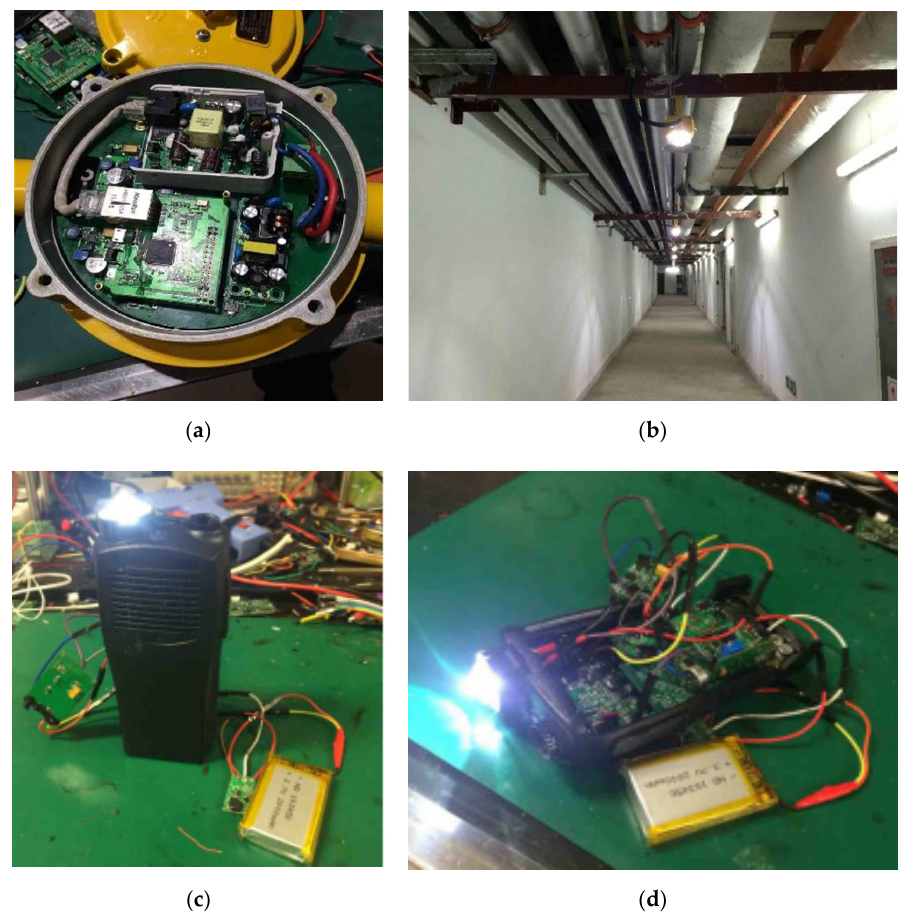
Figure 14. The IWOC-PLC integrated duplex communications network: ( a ) The LED fixture with DF module and IWOC-PLC coupler [17]; ( b ) overview of IWOC-PLC access network [17]; ( c ) duplex IWOC handheld terminal [17]; ( d ) R X & T X modules in handheld terminals [17].